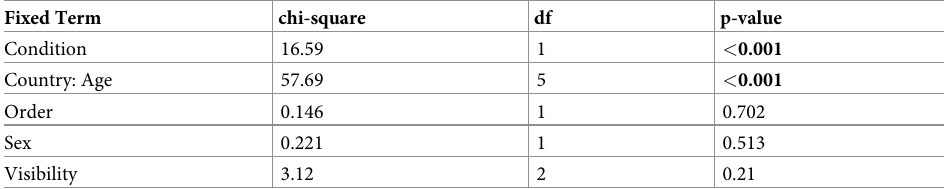
Table 2. Generalized linear mixed models for Experiment 2.